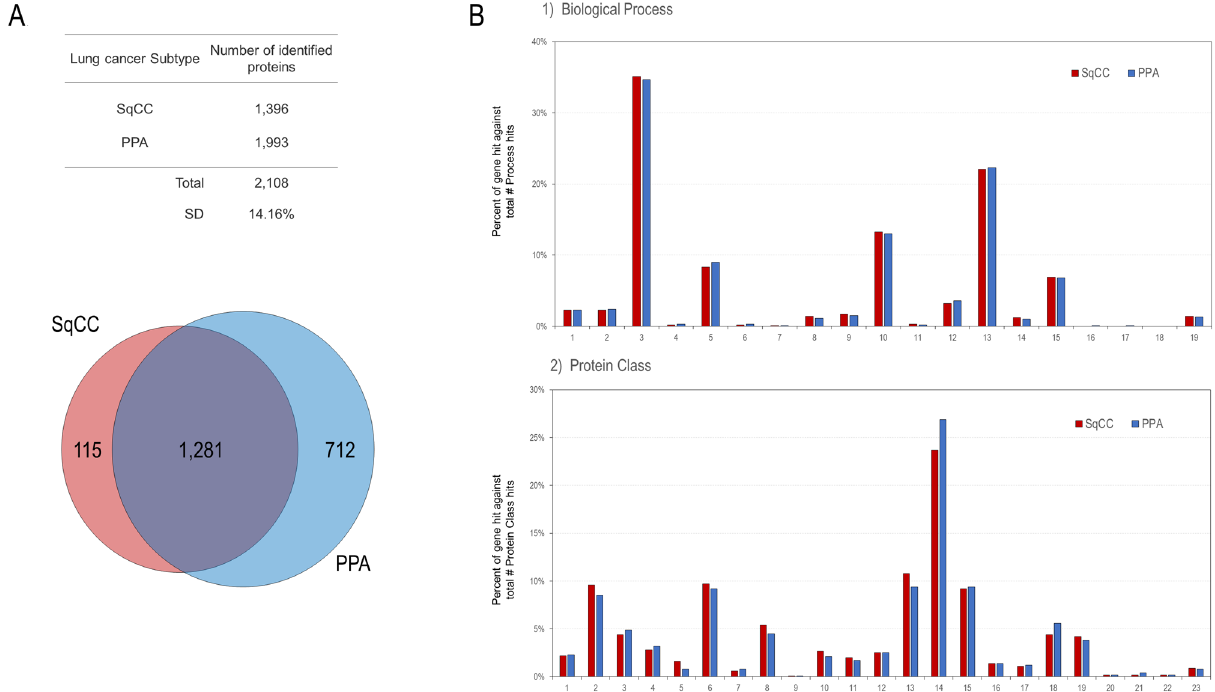
Figure 1. Venn map and hierarchical clustering of the identified proteins. ( A ) Venn map of the identified proteins. ( B ) Gene ontology (GO) analysis of the identified proteins for SqCC and PPA. (1) Biological process. 1, developmental process (GO:0032502); 2, multicellular organismal process (GO:0032501); 3, cellular process (GO:0009987); 4, reproduction (GO:0000003); 5, localization (GO:0051179); 6, reproductive process (GO:0022414); 7, multi-organism process (GO:0051704); 8, biological adhesion (GO:0022610); 9, immune system process (GO:0002376); 10, biological regulation (GO:0065007); 11, growth (GO:0040007); 12, signalling (GO:0023052); 13, metabolic process (GO:0008152); 14, interspecies interaction between organisms (GO:0044419); 15, response to stimulus (GO:0050896); 16, pigmentation (GO:0043473); 17, biological phase (GO:0044848); 18, behavior (GO:0007610); 19, locomotion (GO:0040011). (2) Protein class. 1, extracellular matrix protein (PC00102); 2, cytoskeletal protein (PC00085); 3, transporter (PC00227); 4, scaffold/adaptor protein (PC00226); 5, cell adhesion molecule (PC00069); 6, nucleic acid metabolism protein (PC00171); 7, intercellular signal molecule (PC00207); 8, protein-binding activity modulator (PC00095); 9, viral or transposable element protein (PC00237); 10, calcium-binding protein (PC00060); 11, gene-specific transcriptional regulator (PC00264); 12, defense/immunity protein (PC00090); 13, translational protein (PC00263); 14, metabolite interconversion enzyme (PC00262); 15, protein-modifying enzyme (PC00260); 16, chromatin/chromatin-binding, or -regulatory protein (PC00077); 17, transfer/carrier protein (PC00219); 18, membrane traffic protein (PC00150); 19, chaperone (PC00072); 20, cell junction protein (PC00070); 21, structural protein (PC00211); 22, storage protein (PC00210); 23, transmembrane signal receptor